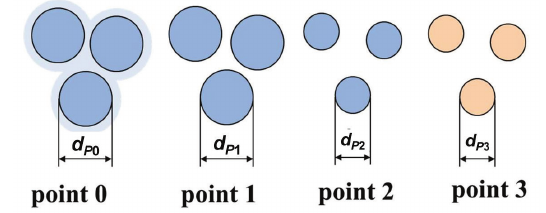
Pavel Hoffman: Effect of fluidized bed stirring on drying process of adhesive particles